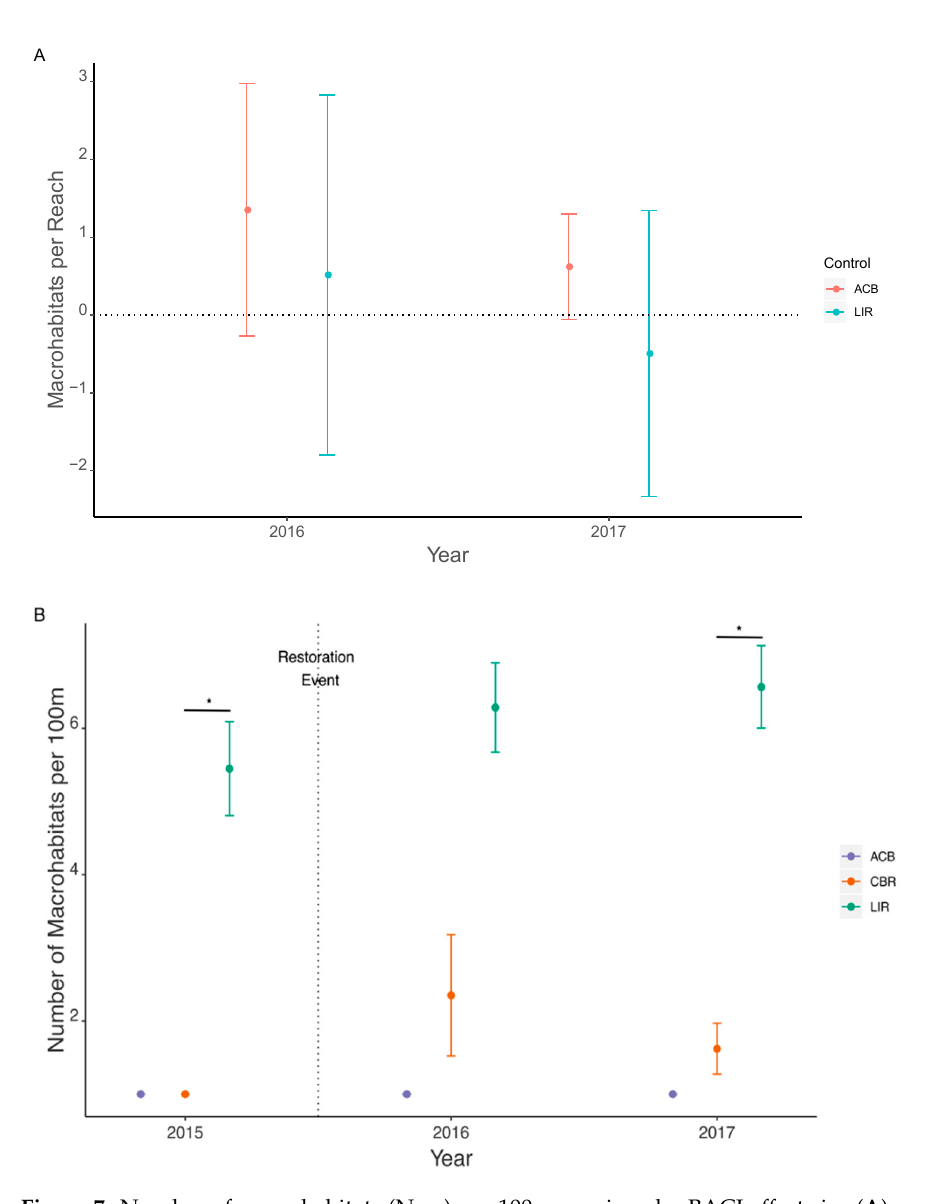
Figure 7. Number of macrohabitats (N hab ) per 100 m as given by BACI effect size ( A ) and actual values with standard error ( B ). Significant differences are not observed for effect size, with confidence interval ranges not overlapping zero ( A ) while significant pairwise Welch’s t -tests ( α = 0.008) between CBR and other treatments within each year are marked with (*) ( B ). ACB = active cranberry bog, CBR = cranberry bog restoration, LIR = least impacted reference. All statistical comparisons are listed in Supplemental Table S4A and Supplemental Table S5B.